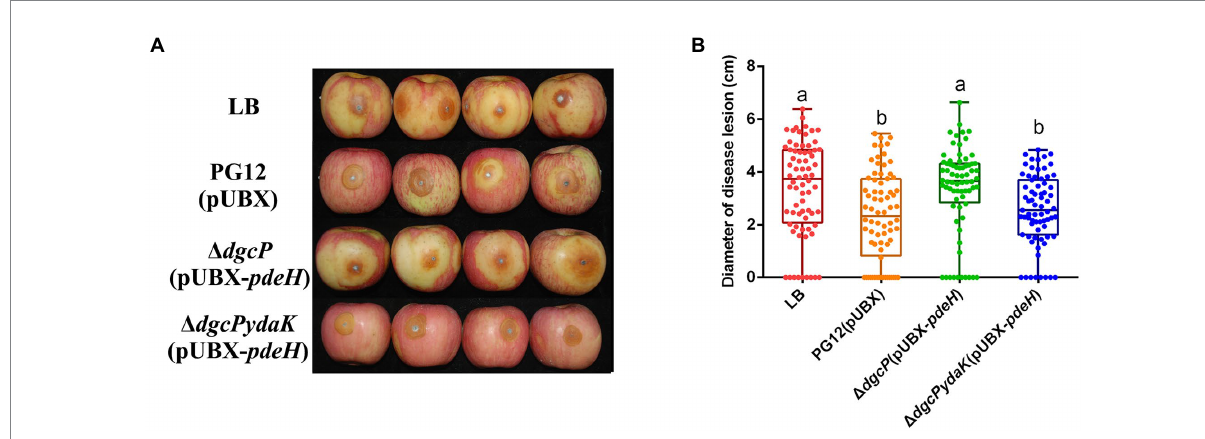
FIGURE 9 Deletion in the ydaK gene rescued the inhibition of biocontrol efficacy by low c-di-GMP level. Bacteria were incubated for 48 h in LB broth supplemented with 1% (w/v) xylose at the final concentration. Biocontrol efficacy was assessed with Fuji apple fruits treated with the cultures of Bacillus velezensis PG12(pUBX) [PG12(pUBX)], Δ dgcP (pUBX- pdeH ), or Δ dgcPydaK (pUBX- pdeH ). LB broth (LB) was used as control. Images were taken (A) and the diameter of disease lesions (B) was measured 7 days post inoculation. Values correspond to the mean diameter of 80 disease lesions from 20 apple fruits. The data is a representative of three independent experiments. Different letters on the column indicate significant differences between different treatments according to the least significant difference (LSD) test ( p < 0.05).